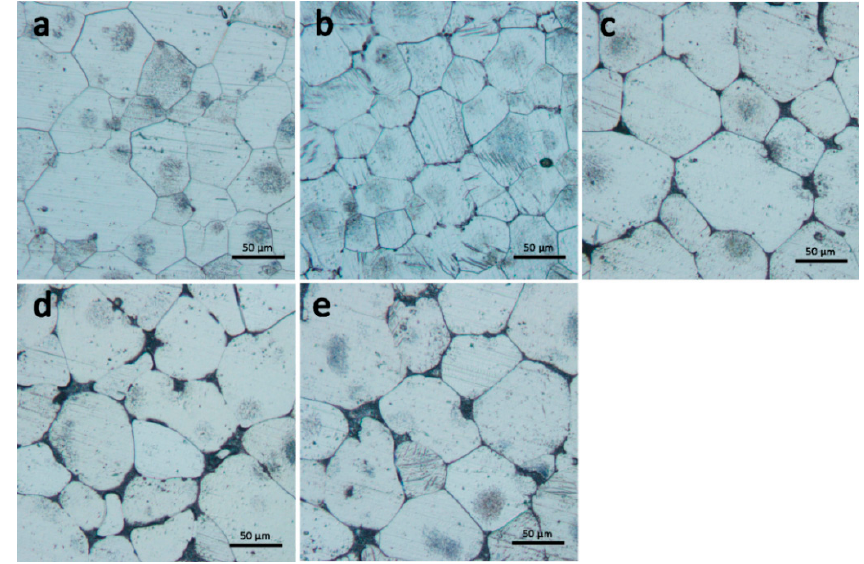
Figure 6. The optical micrographs of solution-treated Mg–4Sm– x Zn–0.5Zr alloys: ( a ) x = 0; ( b ) x = 1; ( c ) x = 2; ( d ) x = 3; ( e ) x = 4.